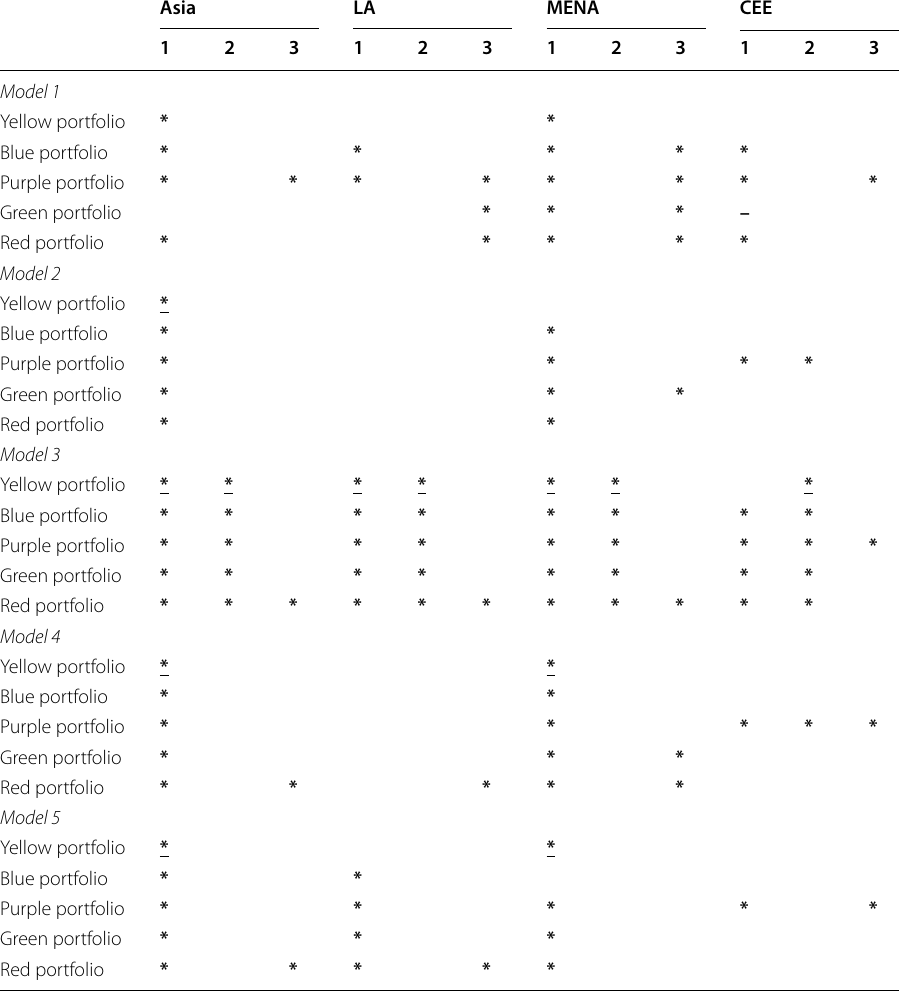
Table 2 Panel cointegration test results relating to correlation based international portfolios: a